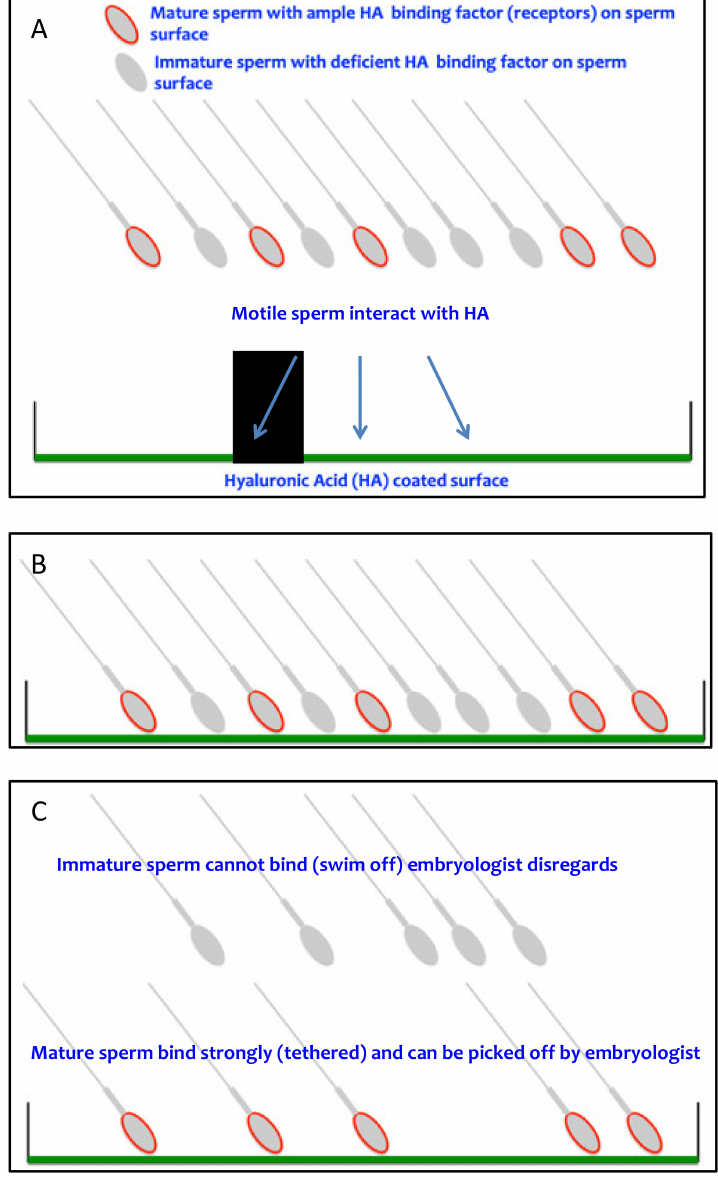
Figure 1. The clinical use of hyaluronic acid binding (HAB)-sperm selection, depicting the introduc- tion of sperm to HA-coated dishes ( A , B ) and the binding of mature sperm to HA ( C ). The bound sperm are selected for intracytoplasmic sperm injection